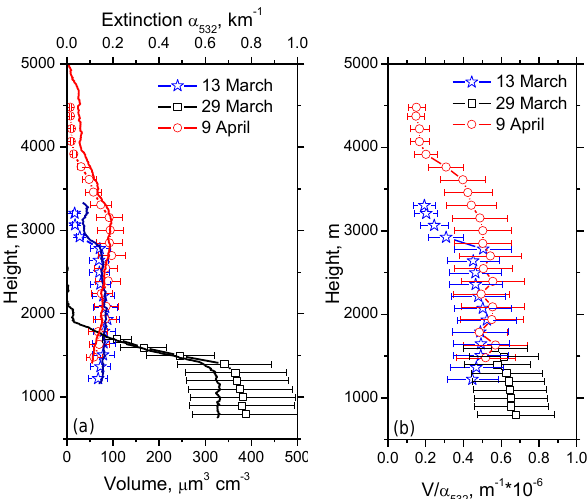
Figure 16. (a) Vertical profiles of the particle volume density V (symbols) retrieved from 3 β + 2 α measurements on 13 March, 29 March, and 10 April. Solid lines indicate the profiles of extinc- tion coefficient at 532nm. (b) The volume–extinction ratio V/α 532 for the days